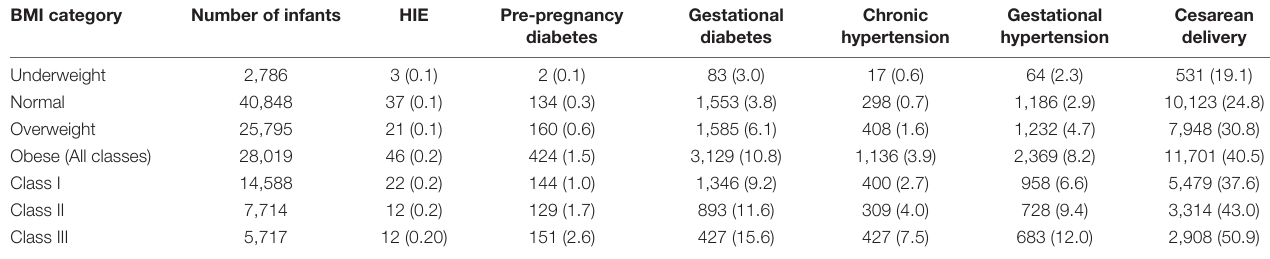
TABLE 2 | Infants with HIE by Maternal NIH-BMI